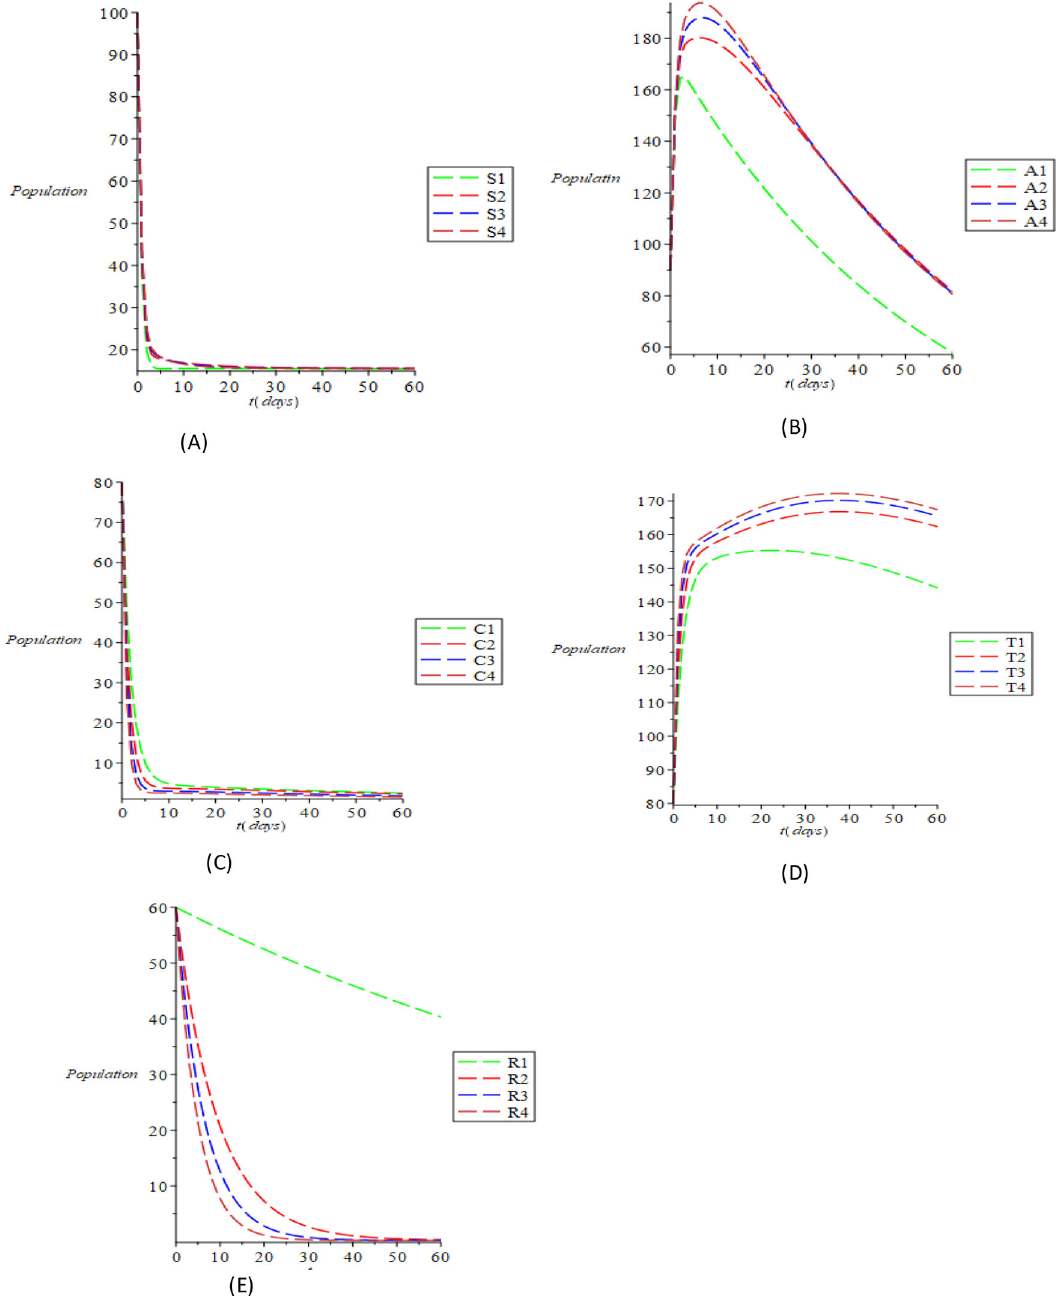
Figure 3. The dynamical behavior of the various classes varying various treatment parameter (A) susceptible (B) acute (C) chronic (D) treated (E) recovered using the Maple 19